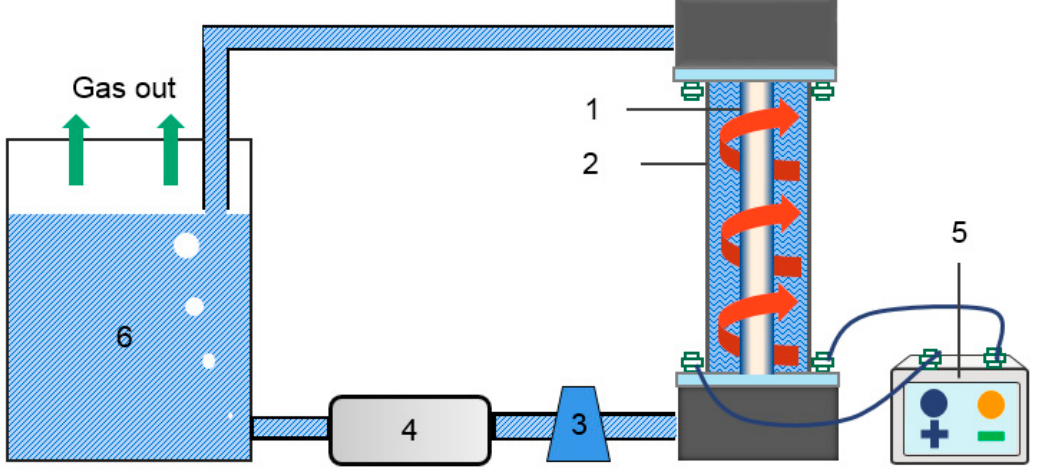
Figure 1. Schematic diagram of cyclone electrodeposition apparatus: 1—anode; 2—cathode; 3—flow meter; 4—pump; 5—electrolysis device; and 6—storage setting tank.